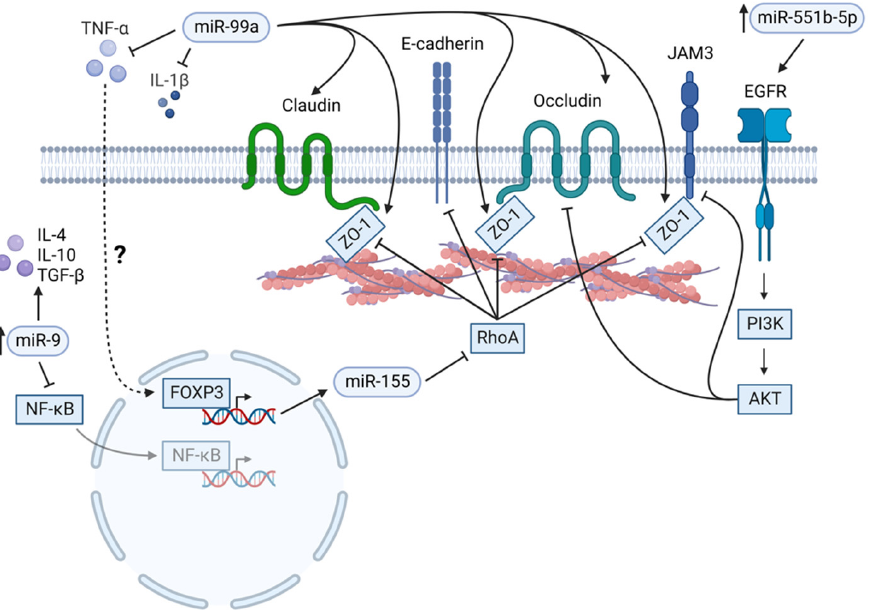
Figure 3. MiRs’ role in tight junctions in SAP (please see text for details). Created with BioRen- der.com.